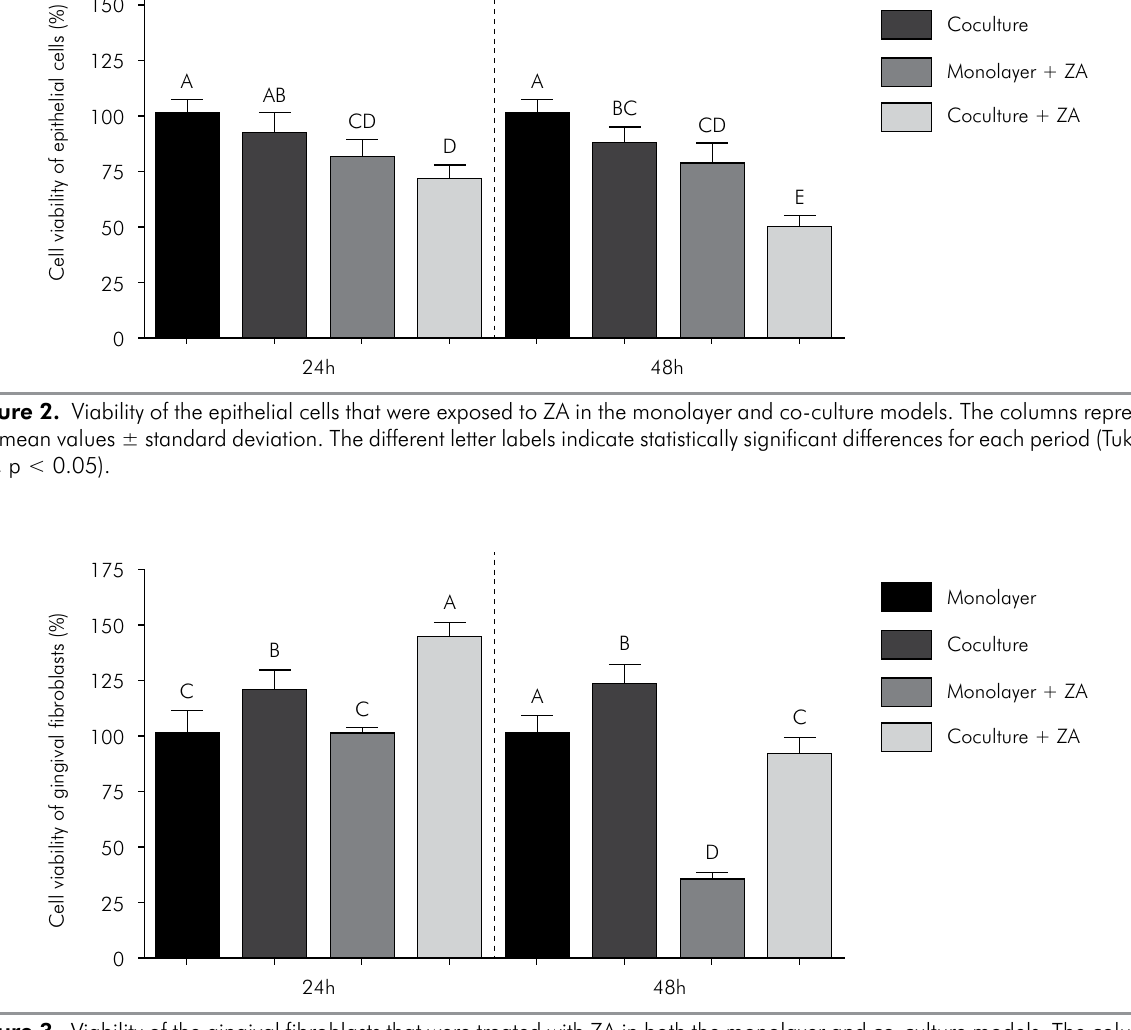
Figure 3. Viability of the gingival fibroblasts that were treated with ZA in both the monolayer and co-culture models. The columns represent the mean values ± standard deviation. The different letter labels indicate statistically significant differences for each period (Tukey’s test, p <